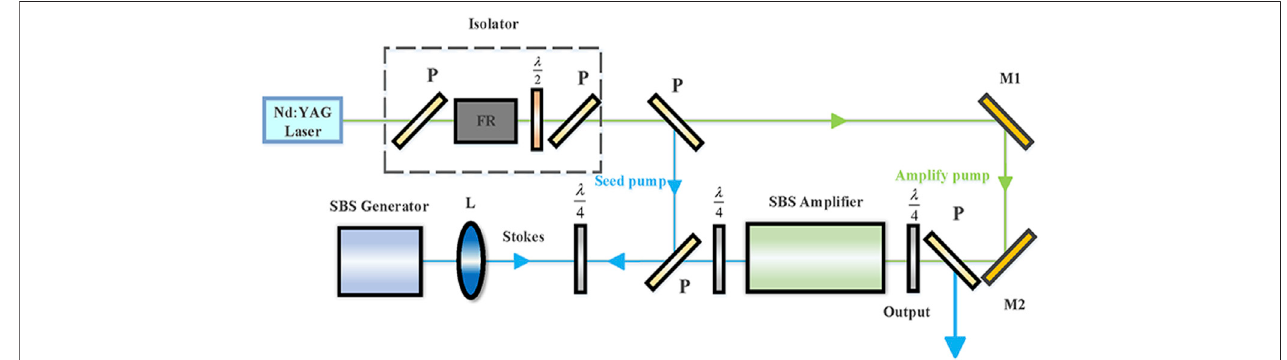
FIGURE 7 | Schematic diagram of basic independent two-cell